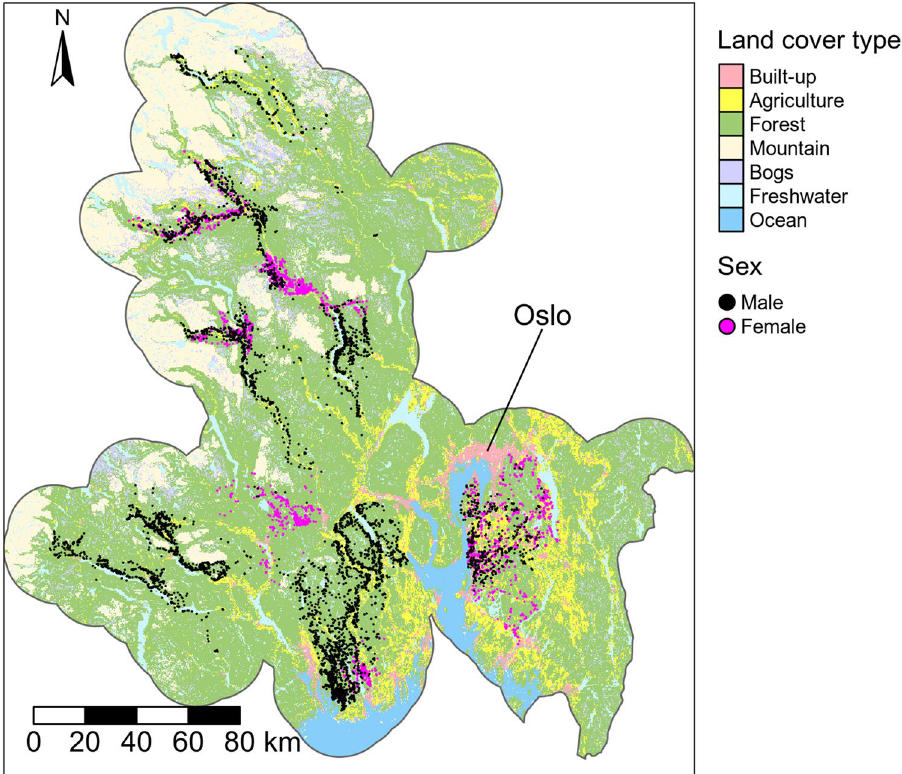
Figure 1. Location of the study area (coloured region) and GPS-locations of lynx (black and pink dots). The study area was delineated by drawing an 18-km buffer around all lynx GPS-locations. The figure was created using the R package tmap (version 3.2, https:// cran.r- proje ct. org/ web/ packa ges/ tmap/ index.